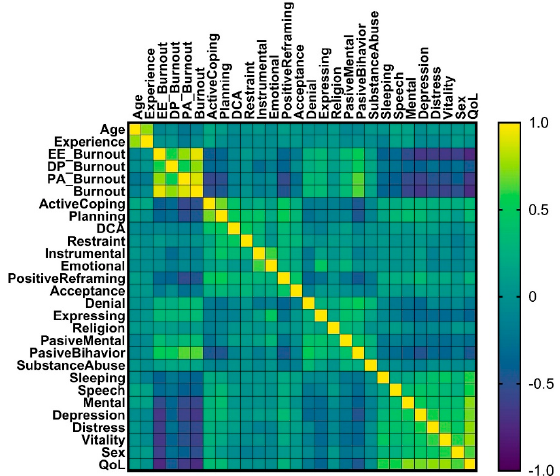
Figure 4. Heatmap